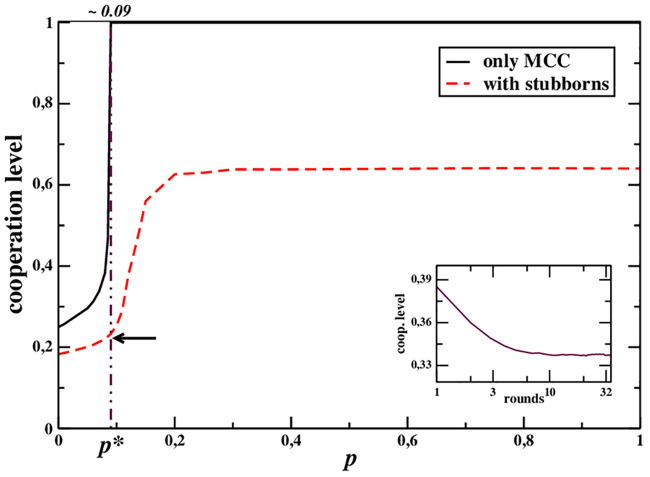
Long-term cooperation level reached by a population of agents interacting on a square lattice playing a PDG as described in [18].The population is composed either exclusively of MCC agents (black line), or of a mixture of MCC players and “stubborns”, that is, absolute cooperators and absolute defectors, in a proportion equal to that reported in [18] (about 65%, 5%, and 30%, respectively). The results are illustrated as a function of p, being the remaining parameters fixed to the experimental values q = 0.2, r = 0.4; the arrow points at the experimental outcome, showing that the system of agents is very close to p*. Inset: Time behaviour (i.e., as game rounds go by) of the cooperation level for a system with p ≃ p* (empirical value), which is qualitatively very similar to the experimental one (see Fig 1 of Ref. [18]).